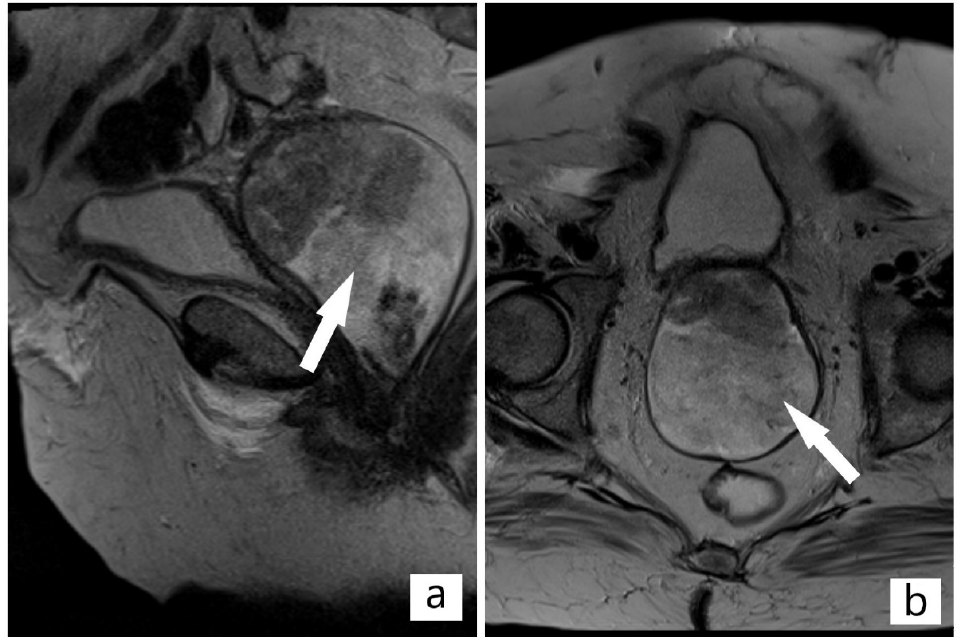
Figure 2. ( a , b ) Magnetic resonance imaging (MRI) of the pelvis: Solid mass located at the vaginal vault, intensly gadophilic, extending to the lower 1/3 part of the vagina, no direct infiltration of the urinary bladder (Arrow indicates the tumor).